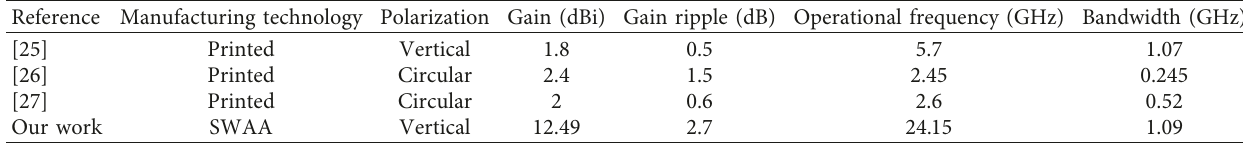
Figure 8: The novel SWAA radiation pattern characterization at 24.15GHz. (a) Azimuth. (b) Elevation. Table 3: Comparison among multiple omnidirectional